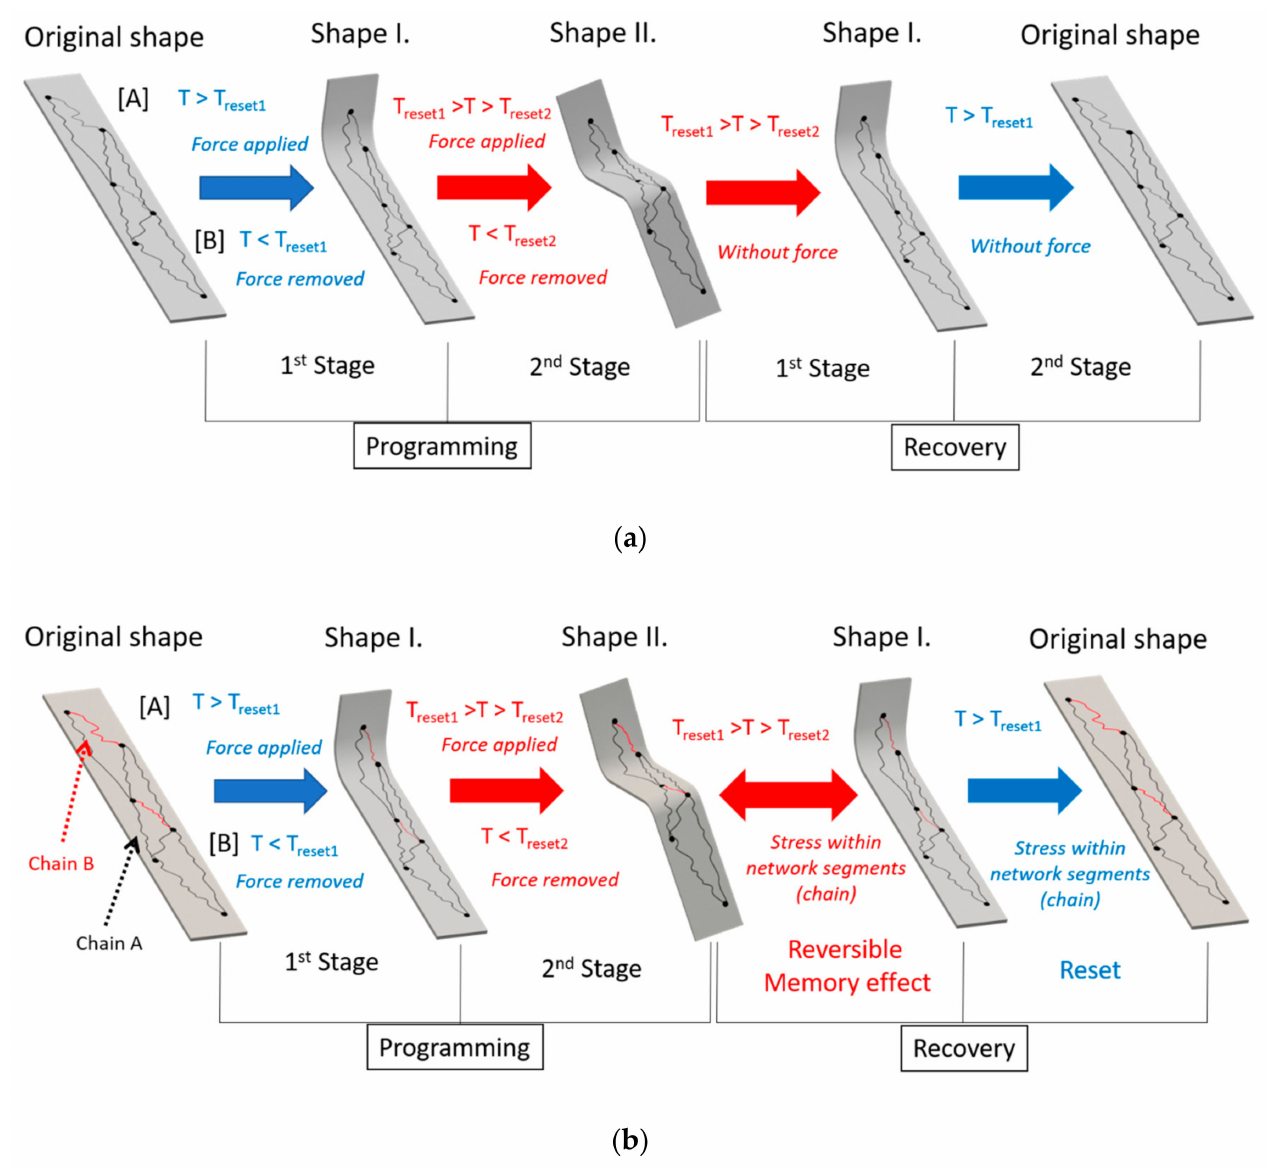
Figure 2. Programming-recovery cycle of shape memory polymers (SMP): ( a ) irreversible memory effect, and ( b ) reversible memory effect. Here [ A ] stands for first step and [ B ] for the second step of the programming. Table 2. The fundamental mechanical and physical properties of SMPs